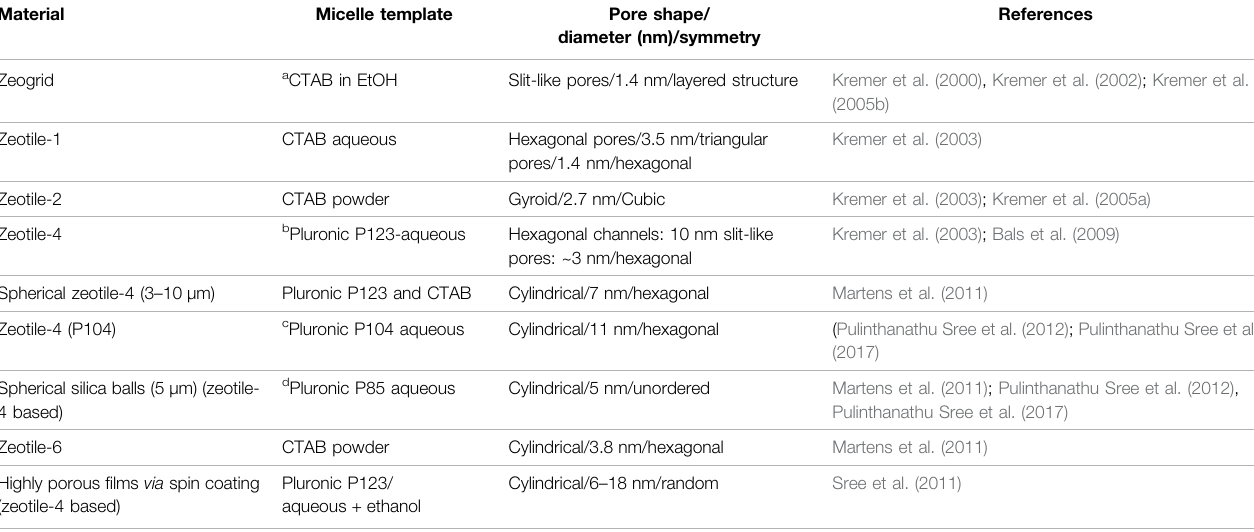
TABLE 1 | Hierarchical silicate materials created using the nanoslab approach. Material